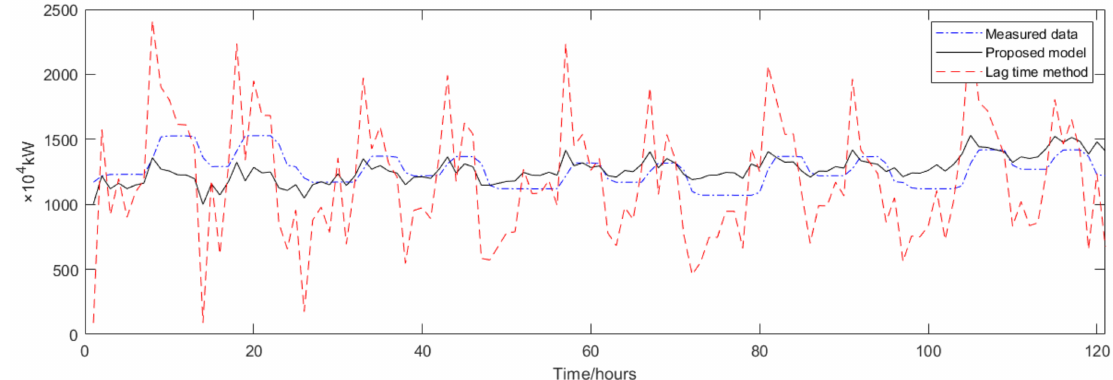
Figure 10. Comparison of the results from the traditional method with the proposed model.